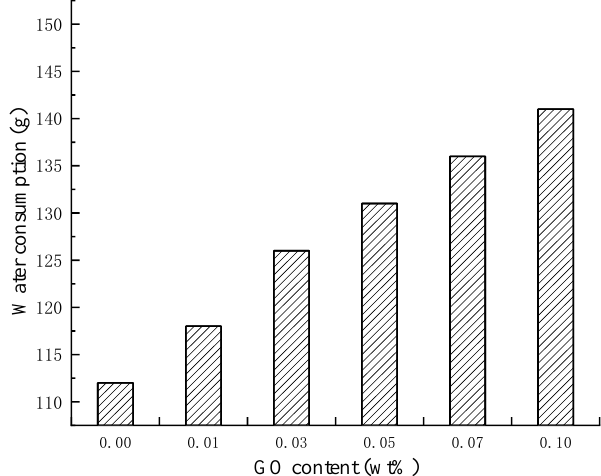
Figure 9. Water consumption for standard consistency with different GO contents.